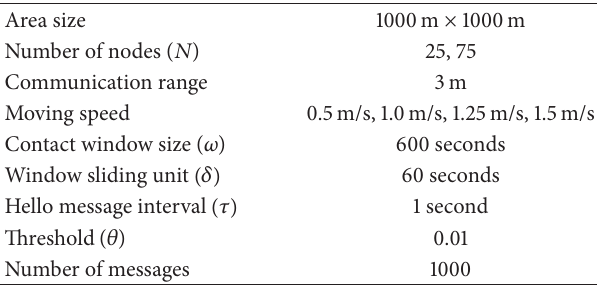
Table 1: Simulation